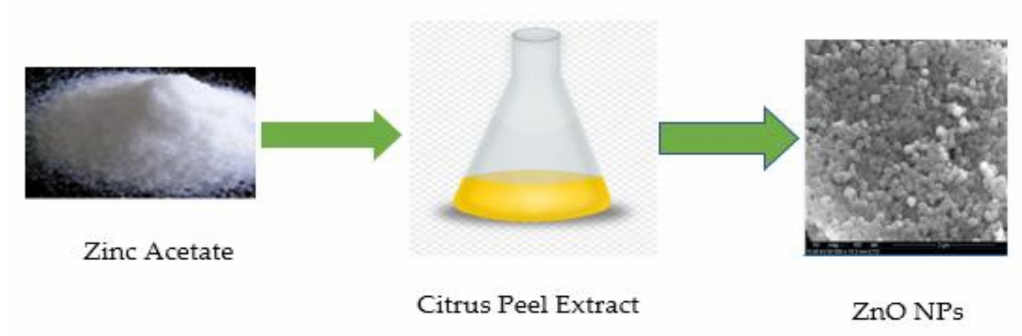
Figure 1. Schematic representation of ZnO NPs